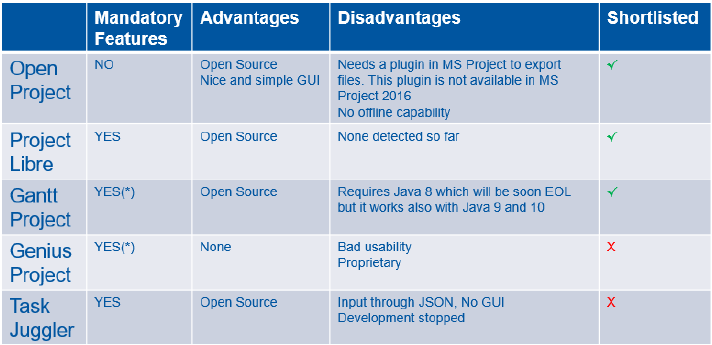
Figure 5. Market Analysis - Assessment Table during one of the